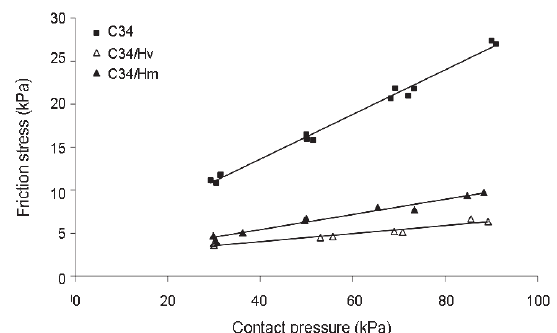
Fig. 11. Evolution of friction stress as a function of contact pressure for C34 with release agent